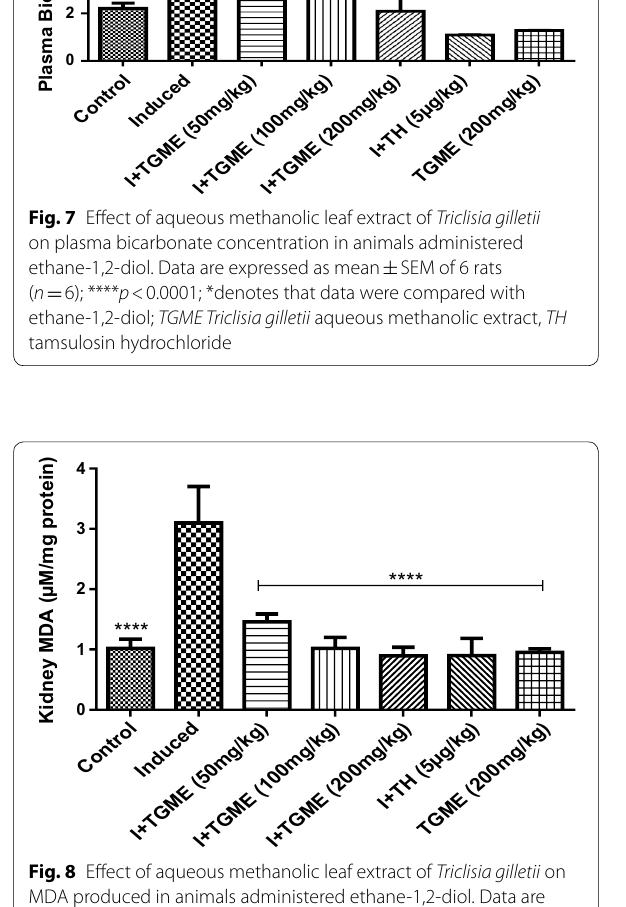
SEM of 6 rats ( n 6); ± =